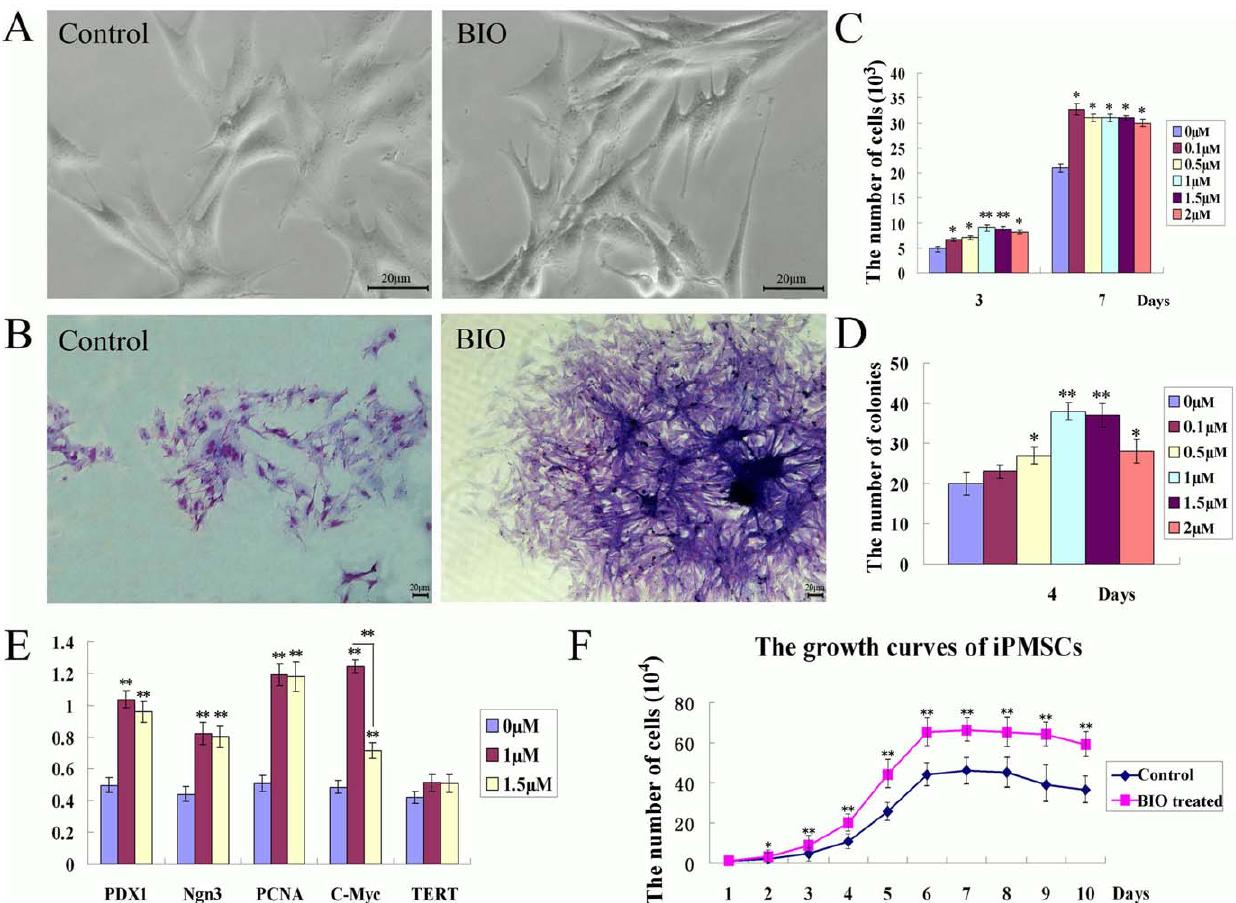
Figure 1. Morphology of iPMSCs in the absence or presence of BIO. A-Control, The typical spindle fibroblast-like morphology of iPMSCs; A- BIO, The morphology of iPMSCs treated with BIO; B, iPMSCs stained with Giemsa in the absence or presence of BIO; C, The number of cells cultured in the absence or presence of BIO (0.1, 0.5, 1.0, 1.5, 2.0 m M); D, The number of iPMSCs colonies; E, Expression of PDX1, PCNA, Ngn3, TERT and C-Myc were analysed at mRNA level in the absence and presence of 1.0 and 1.5 m M BIO; F, The growth curves of iPMSCs cultured in the absence and presence of BIO (1 m M). Bar=20 m m. * P , 0.05, **, P , 0.01.